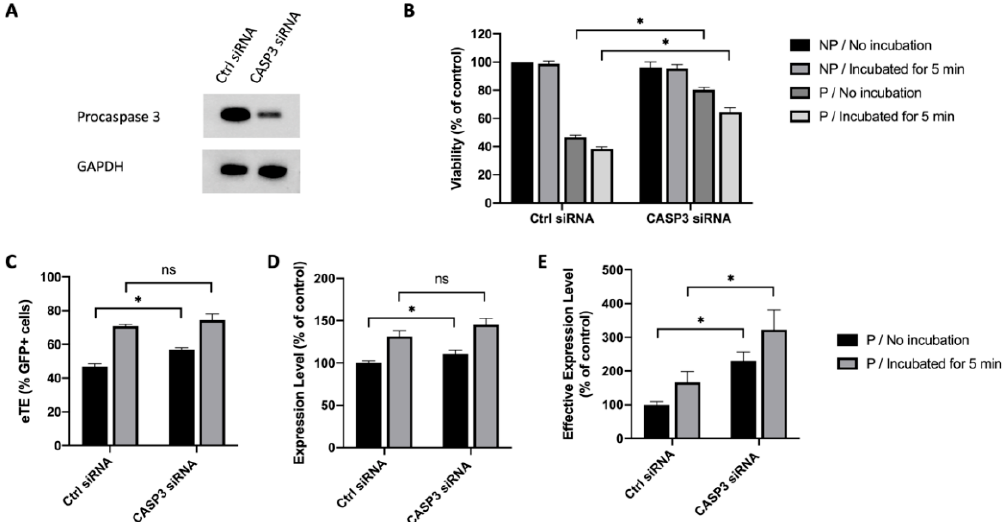
Figure 6. Effects of procaspase 3 knockdown on cell viability and EGFP expression in NIH/3T3 cells. ( A ) Western blot analysis showing the reduction in procaspase 3 expression after procaspase 3 knockdown with CASP3 siRNA treatment; ( B ) Cell viability; ( C ) eTE; ( D ) expression level; ( E ) effective expression level. Pulsing condition: 650 V/0.2 cm, 400 µs, 1 pulse. NP, non-pulsed control; P, pulsed cells; ns, non-significant. Error bars, SEM; * p < 0.05, Student’s t -test, N = 6.